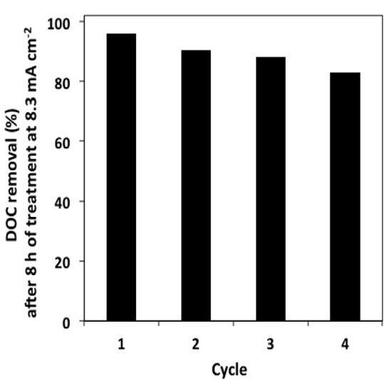
DOC removal after 8h of electrolysis vs number of cycles for the heterogeneous EF treatment using FeIIFeIII-LDH/CF cathode and Pt anode at 8.3 mA cm-2 .